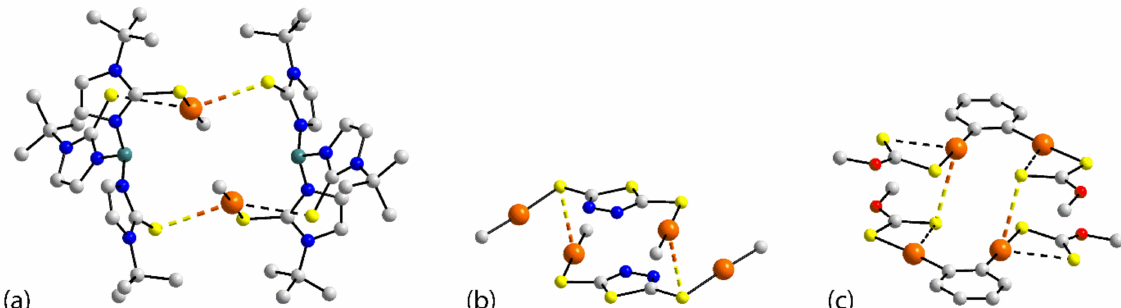
Figure 8. Supramolecular association in zero-dimensional aggregates featuring two Hg ··· S interac- tions: ( a ) 30 , ( b ) 33 and ( c ) 34 . The intramolecular Hg ··· S contacts in ( a , c ) are shown as black dashed lines. Additional colour code: teal—boron.